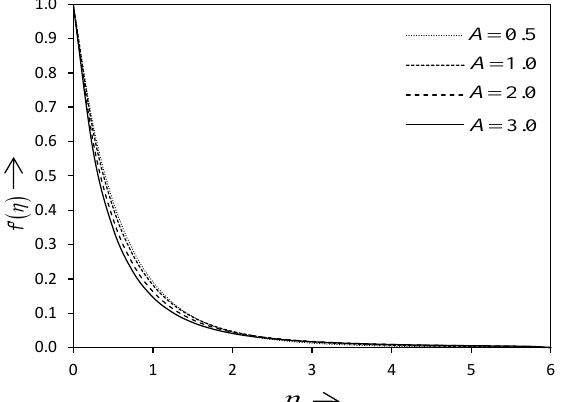
Figure 3. Velocity profiles against  for various values of A with 0 . 1  S